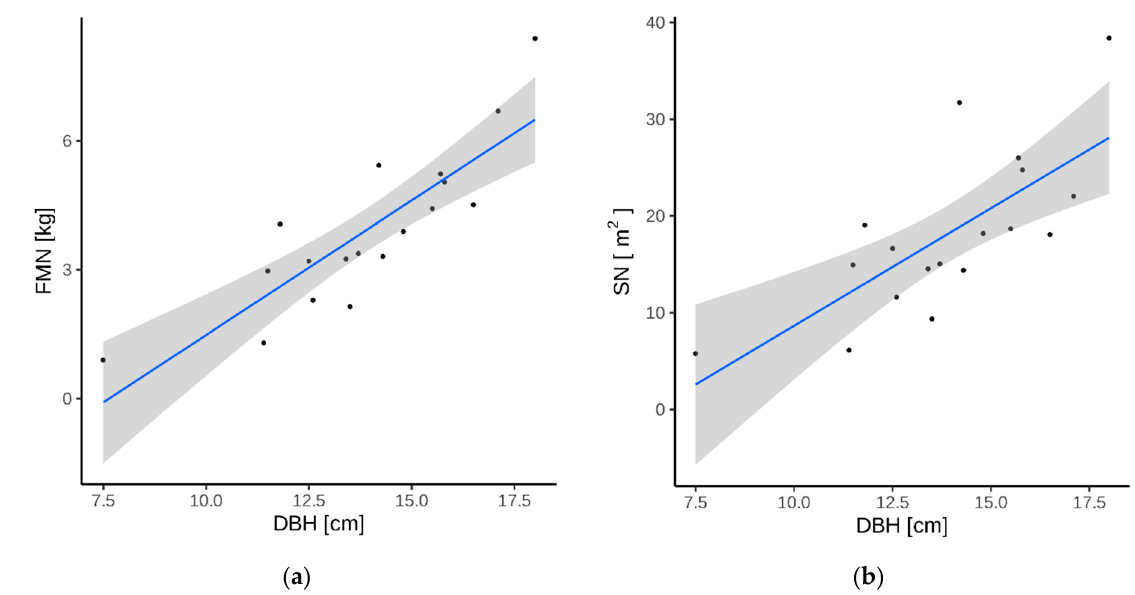
Figure 4. The relationship between: ( a ) the breast height diameter (DBH) and the fresh mass of the needles (FMN), ( b ) the breast height (DBH) and the surface area of the needles (SN). Table 2. Allometric equations for the mass of needles (FMN) and needle surface (SN) determination in Scots pine stands from DBH